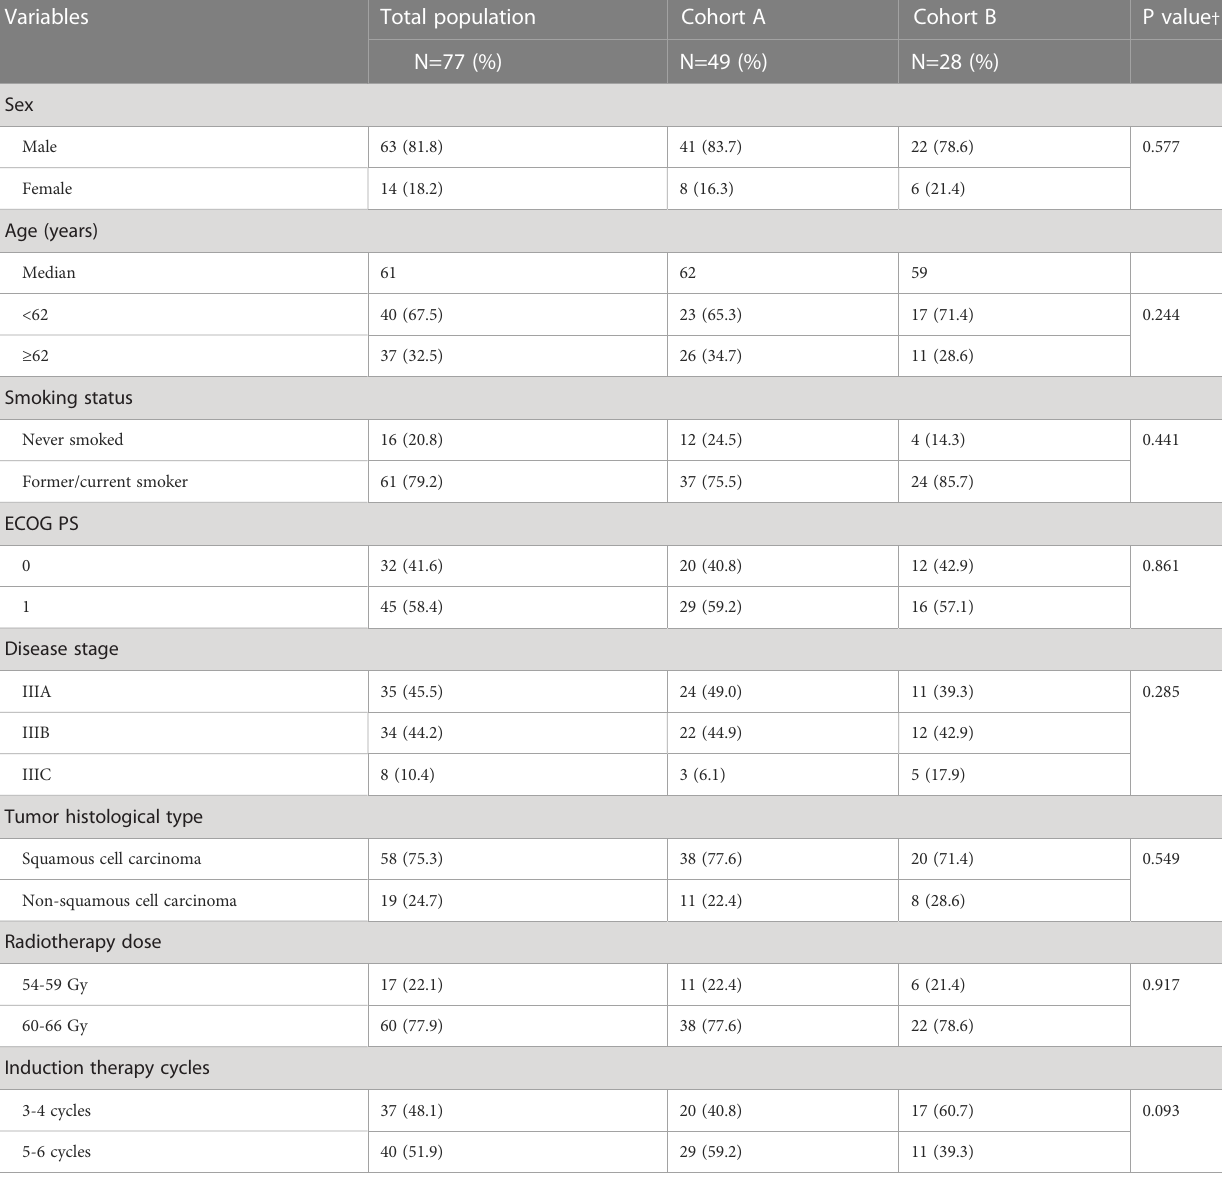
TABLE 1 Baseline characteristics of all